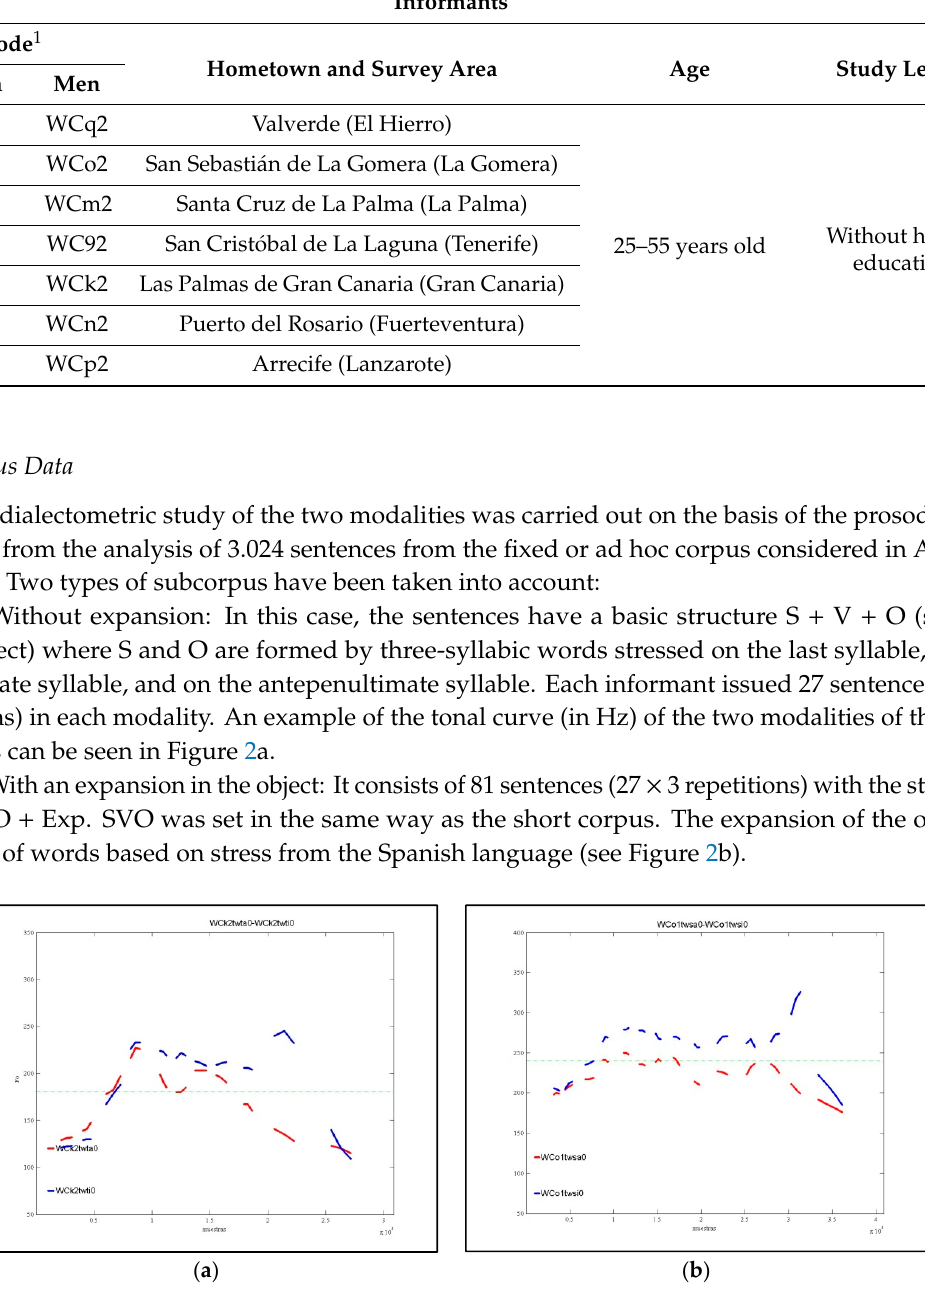
Figure 2. ( a ) Average of F0 from La guitarra se toca con paciencia (‘The guitar is played with patience’)